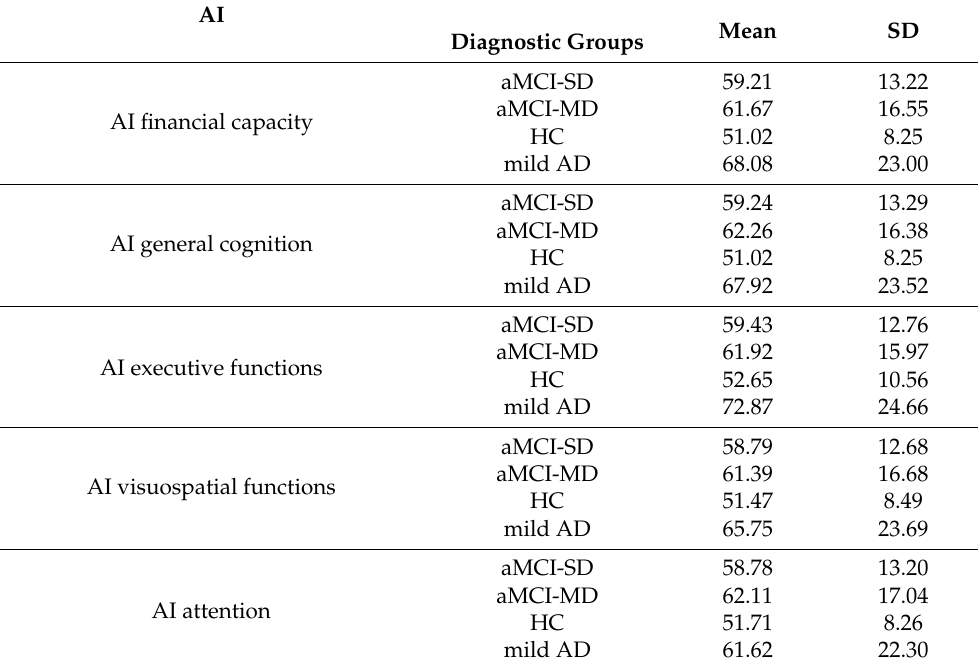
Table 2. Awareness indices (AI) for financial capacity, general cognition, executive functions, visu- ospatial functions, and attention across diagnostic